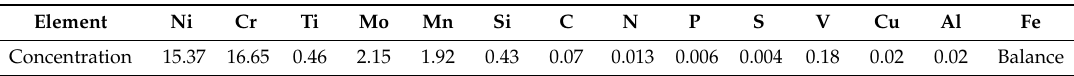
Table 1. Chemical composition of the austenitic stainless steel 15-15Ti